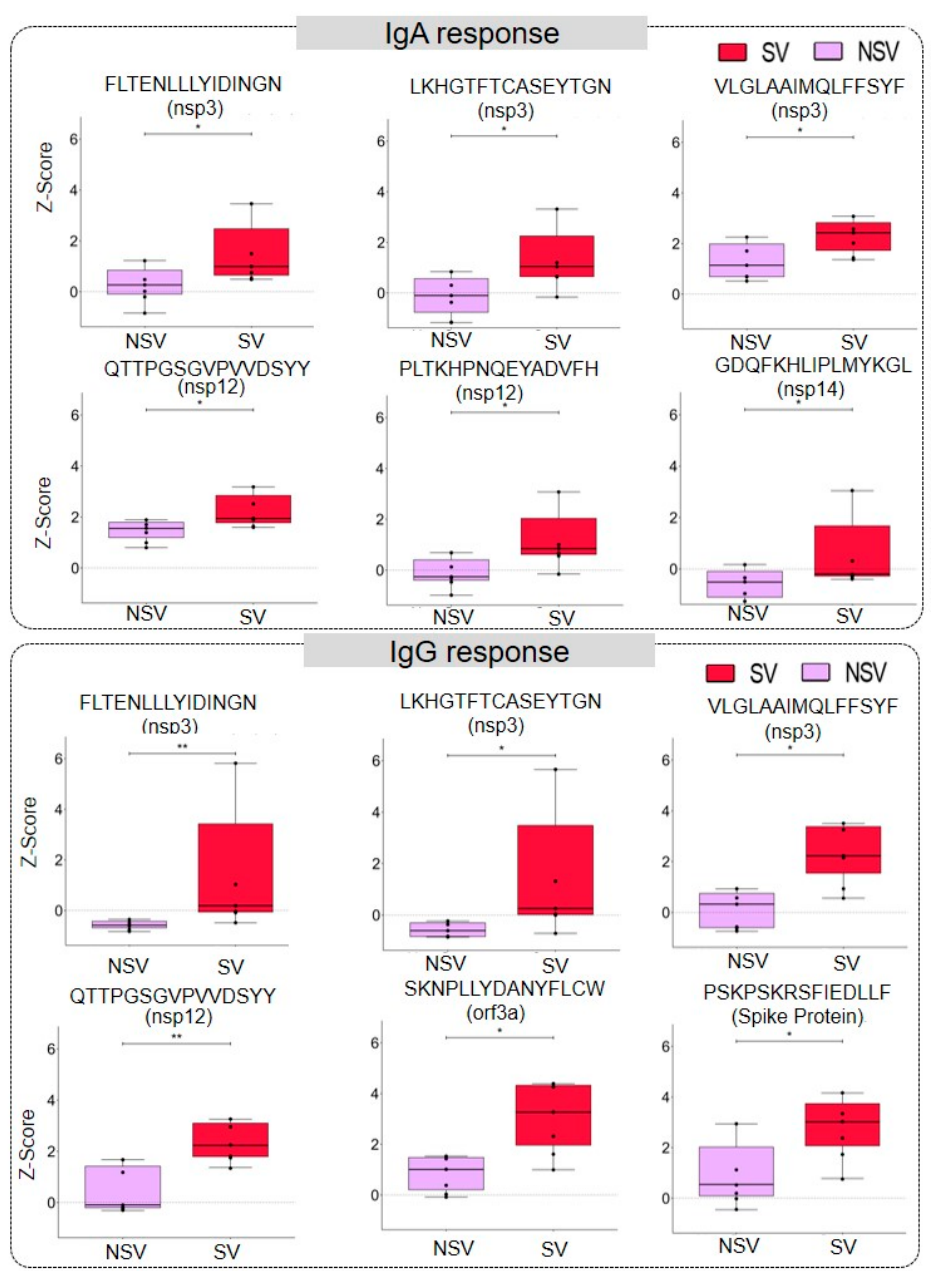
Figure 3. Severity-based discrimination in IgA and IgG response against SARS-CoV-2 peptides. The representative box plot showing IgA and IgG response against a particular peptide in severe (SV) and non-severe (NSV) COVID-19 patients. The significance was calculated using a Mann–Whitney U-Test with a p -value < 0.05 (the p -values between 0.05 and 0.01 are represented using ‘*’ and those between 0.01 and 0.001 by